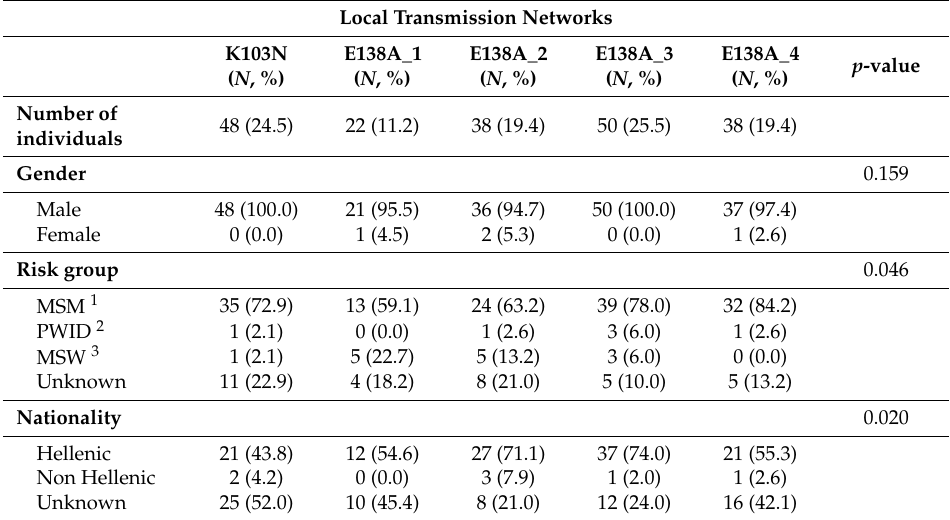
Table 2. Characteristics of the study population infected with subtype A1 non-nucleoside reverse transcriptase inhibitors (NNRTI)-resistant viruses spread to local transmission networks